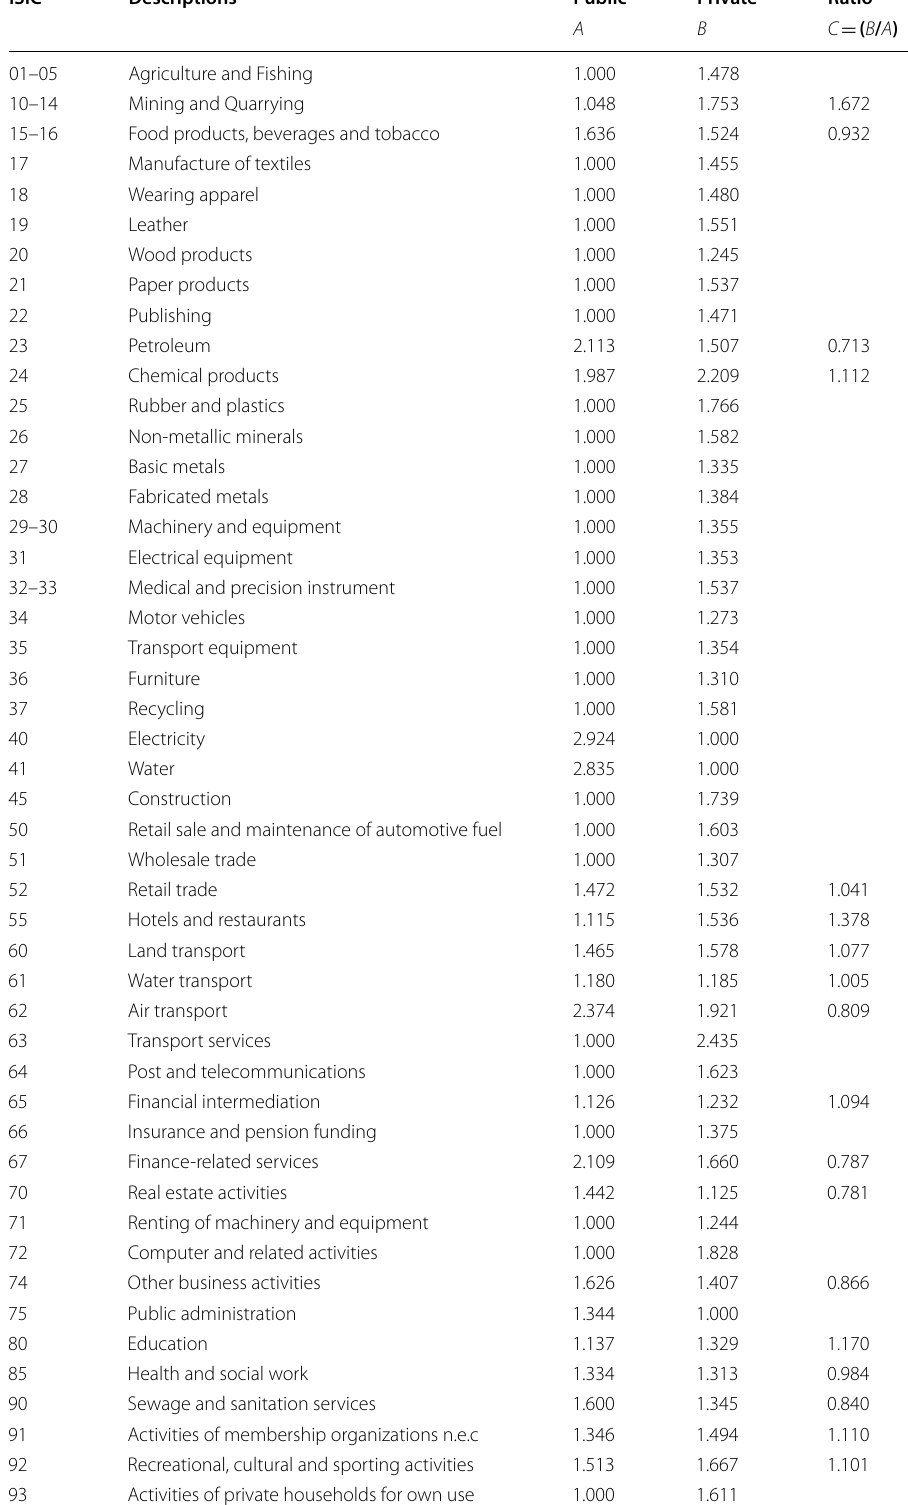
Table 4 Output multipliers. Source: computed by the authors based on CSB (2013)